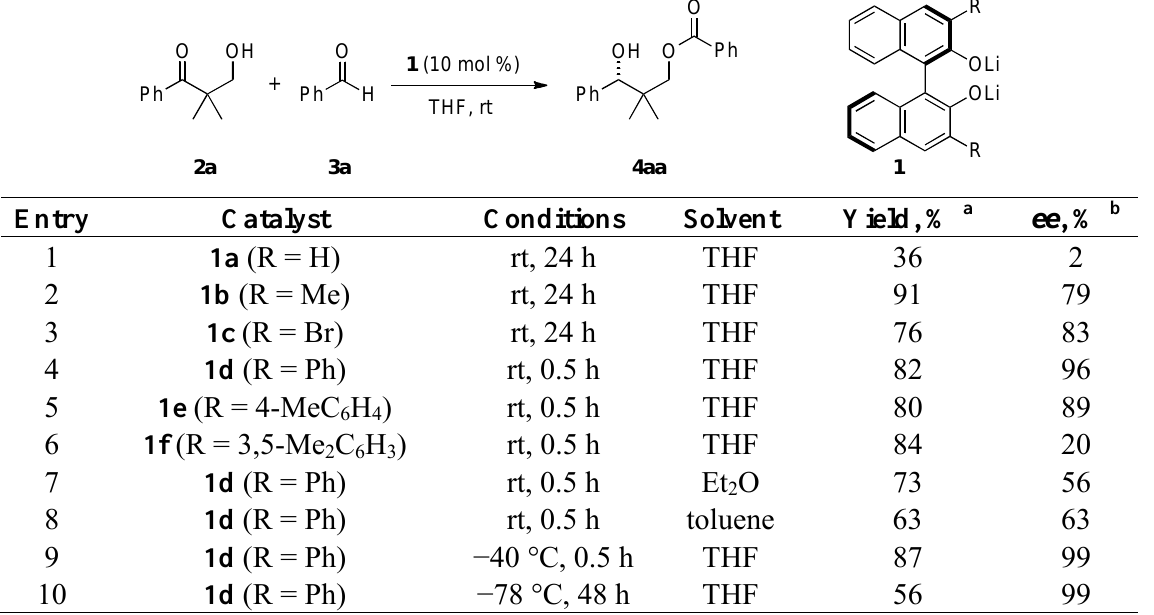
Table 1. Evans-Tishchenko reduction of α , α -dimethyl- β -hydroxypropiophenone. O Ph